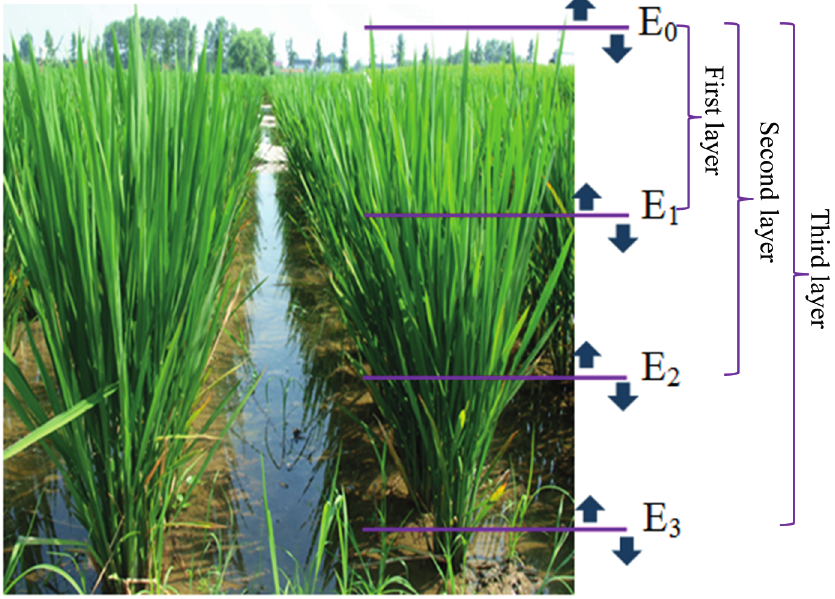
Figure 1. Sketch map for measuring irradiance in the rice